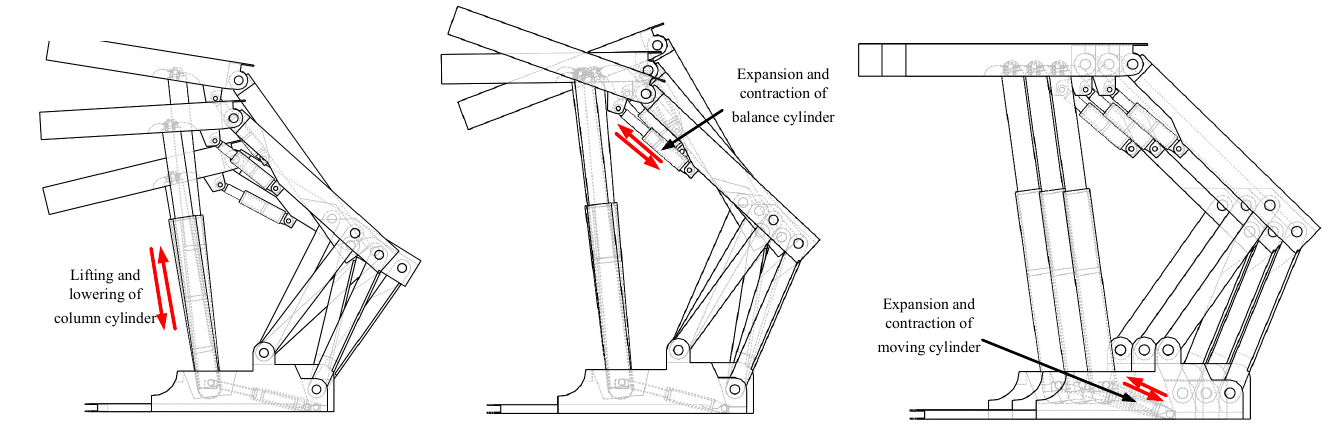
Figure 20. Schematic diagram of hydraulic support following motion. The following motion experiment of the column cylinder: firstly, set the balance cylinder and the moving cylinder of the two supports to remain motionless and control the column cylinder of the reference support to move 50 mm, 100 mm, 150 mm and 200